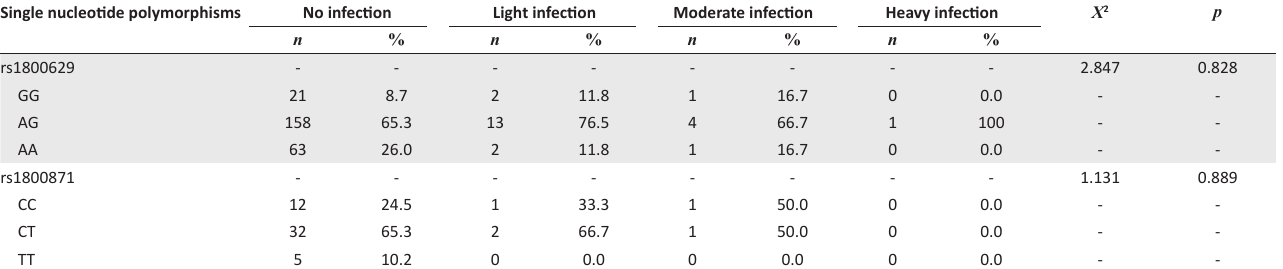
TABLE 3: Genotype distributions of TNF- α (rs1800629) and IL-10-819 T>C (rs1800871) grouped according to S. haematobium infection intensity in preschool children from Madziwa, Shamva district, Zimbabwe, September 2018. Single nucleotide polymorphisms No infection